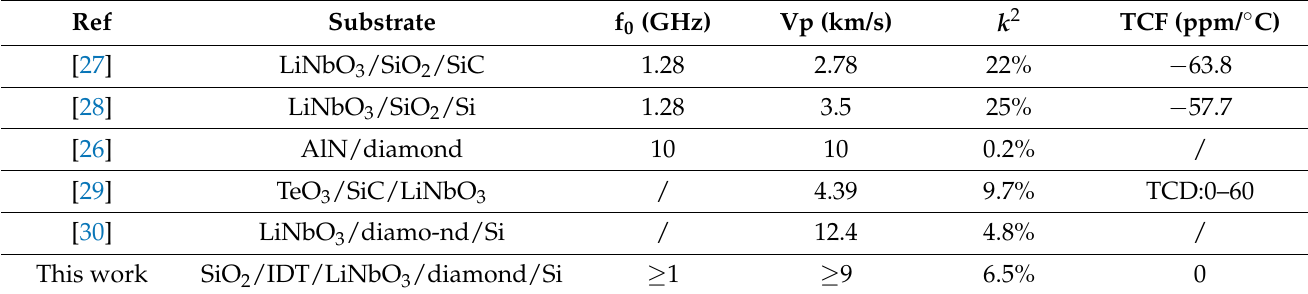
Table 4. SAW parameters of SiO 2/ LiNbO 3 /diamond/Si compared with other material systems. Ref